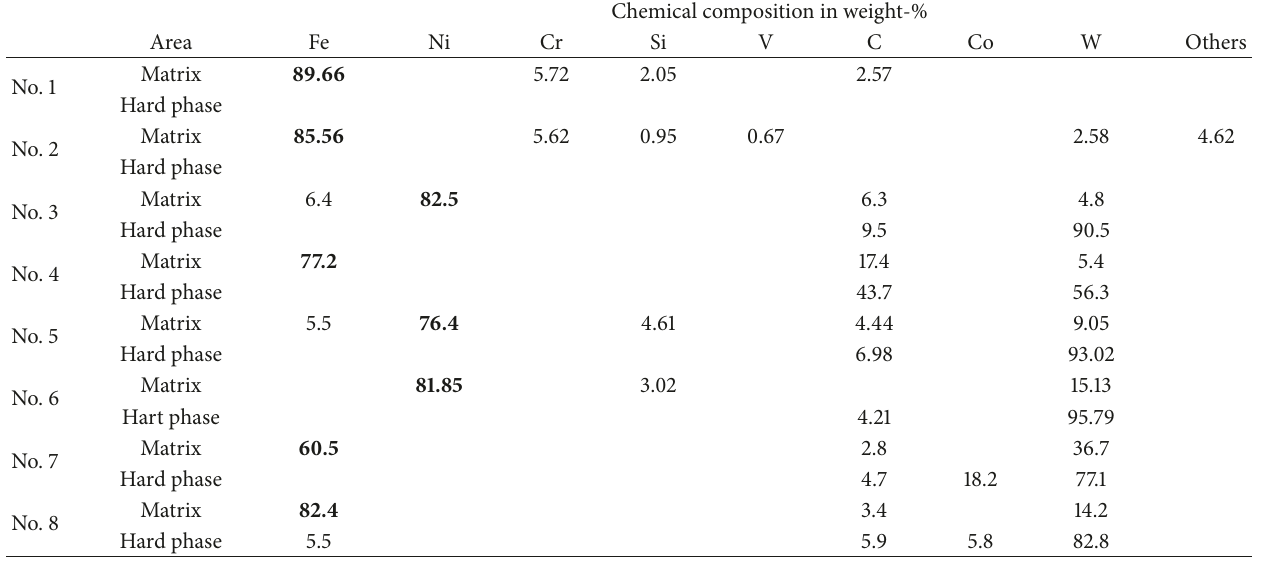
Table 3: Results from EDX analysis in weight percent with an acceleration voltage of 15kV.